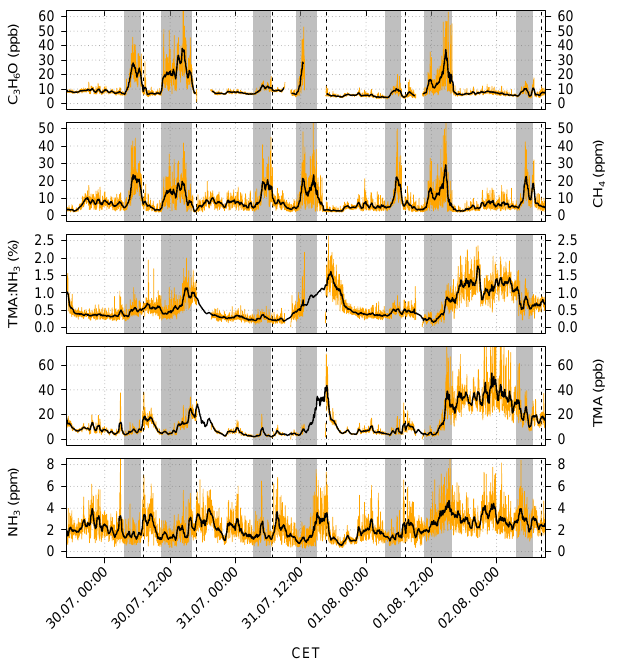
Figure 2. One-minute (orange) and 30min (black) moving average trace gas concentrations measured in the outdoor yard; the presence of the animals is indicated with grey bars; ground scraping is repre- sented by vertical dashed lines.